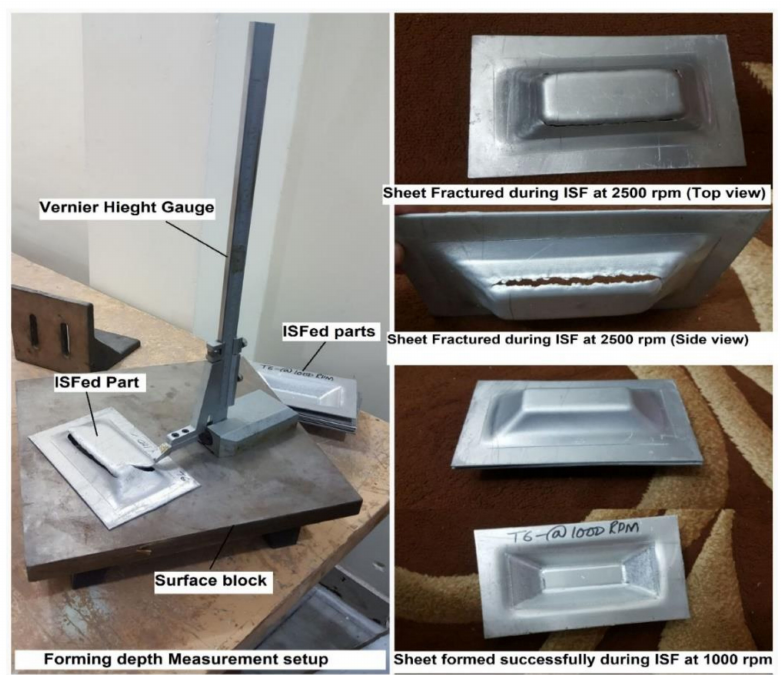
Figure 5. Setup showing measurement of forming depth and representatives of successful and unsuccessful samples.